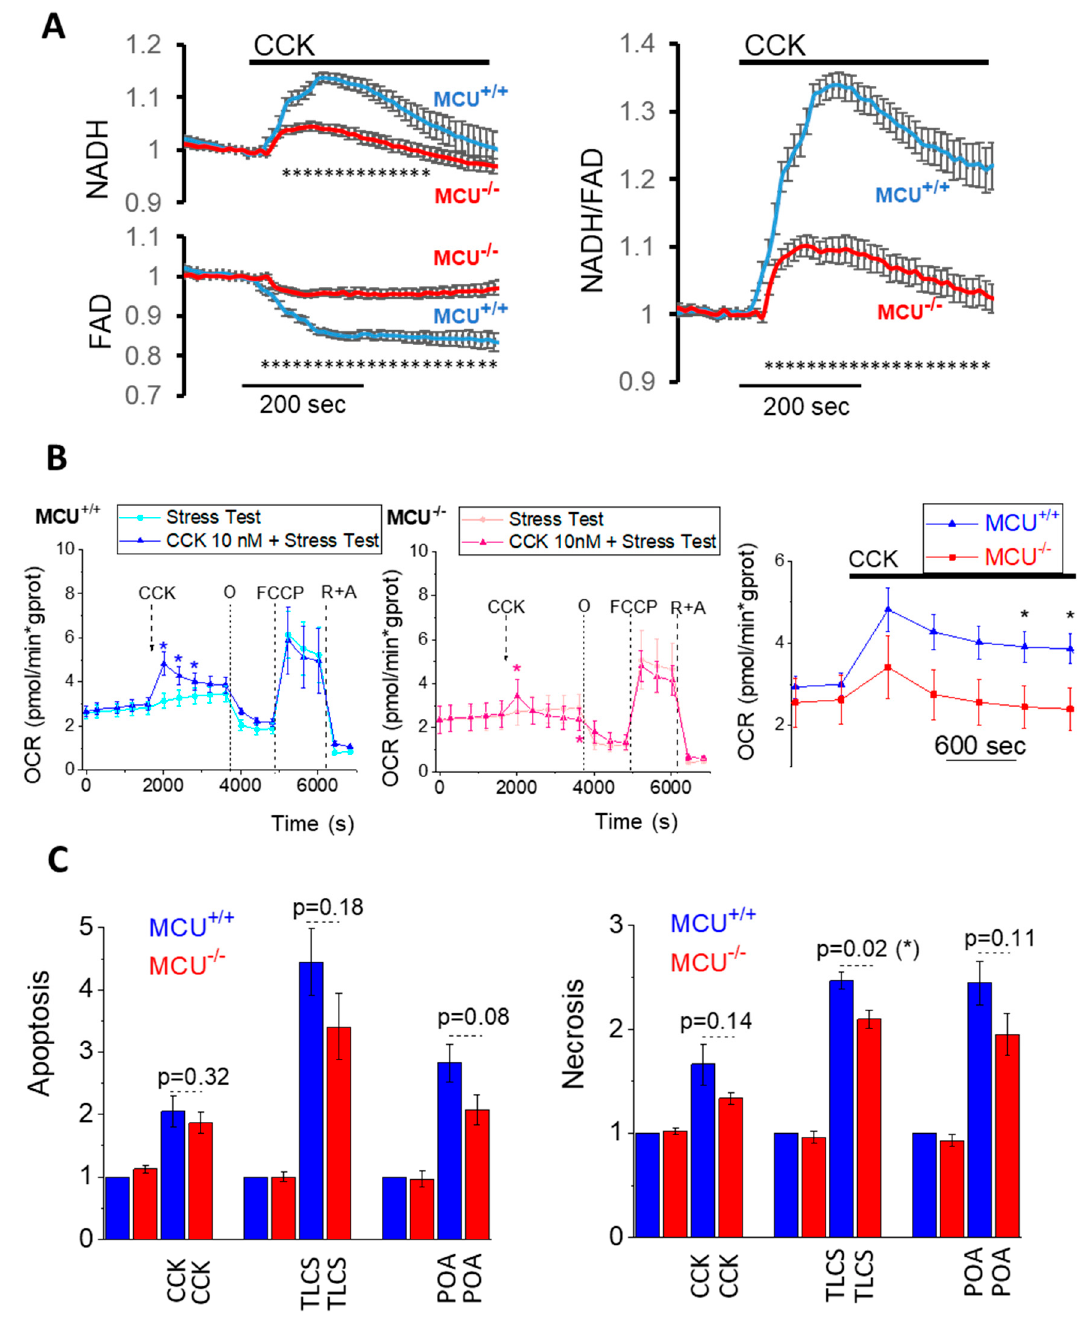
Figure 2. Effect of MCU knockout on NADH/FAD responses, oxygen consumption and cell death of isolated pancreatic acinar cells. ( A ) The left panels show NADH (top) and FAD + (bottom) responses to 1 nM CCK in pancreatic acinar cells isolated from MCU − / − ( n = 57 cells, N = 3 mice) and MCU +/+ ( n = 52 cells, N = 3 mice). Here and in the right panel data are presented as the mean value ± standard error of the mean. Dotted lines under the traces (composed of small asterisks) indicate the periods (from 60 to 290 s following CCK addition for NADH and from 21 to 420 s for FAD + ) when the measurements from MCU +/+ and MCU − / − cells were significantly different ( p < 0.05). The right panel shows the ratio of NAD(P)H to FAD + (calculated for the data shown in the left panels). Dotted line under the traces (composed of small asterisks) indicates the period (from 24 to 420 s following CCK addition) when the measurements from MCU +/+ and MCU − / − cells were significantly different ( p < 0.05). Figure S3 illustrates the differences in the maximal changes of NAD(P)H, FAD + and the ratio of NAD(P)H to